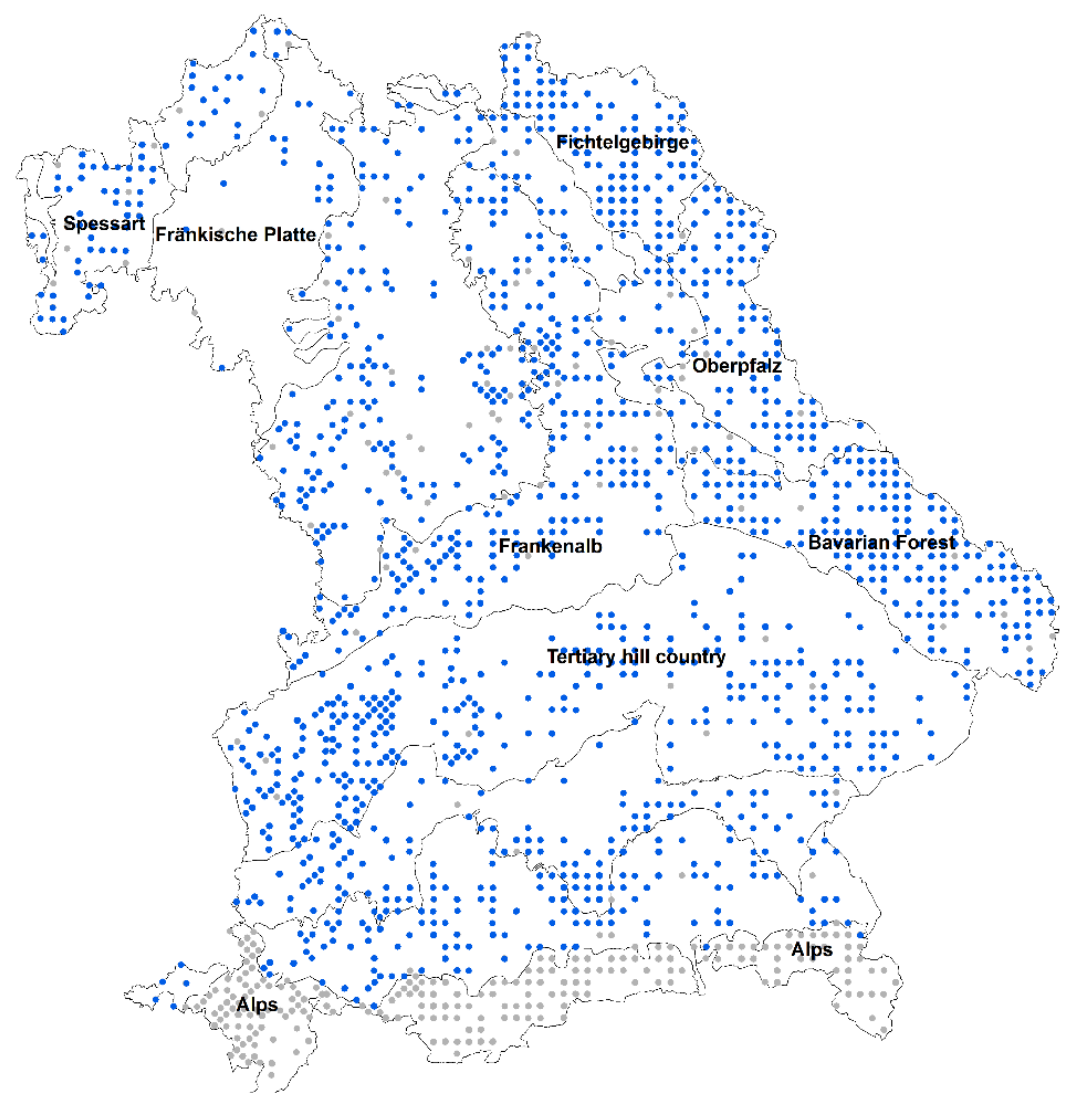
Figure 1. Map of the study area; national forest inventory (NFI) plots used in the SI-model are marked with blue dots, the remaining NFI plots containing spruces are marked with grey dots; eco-regions mentioned in the text are